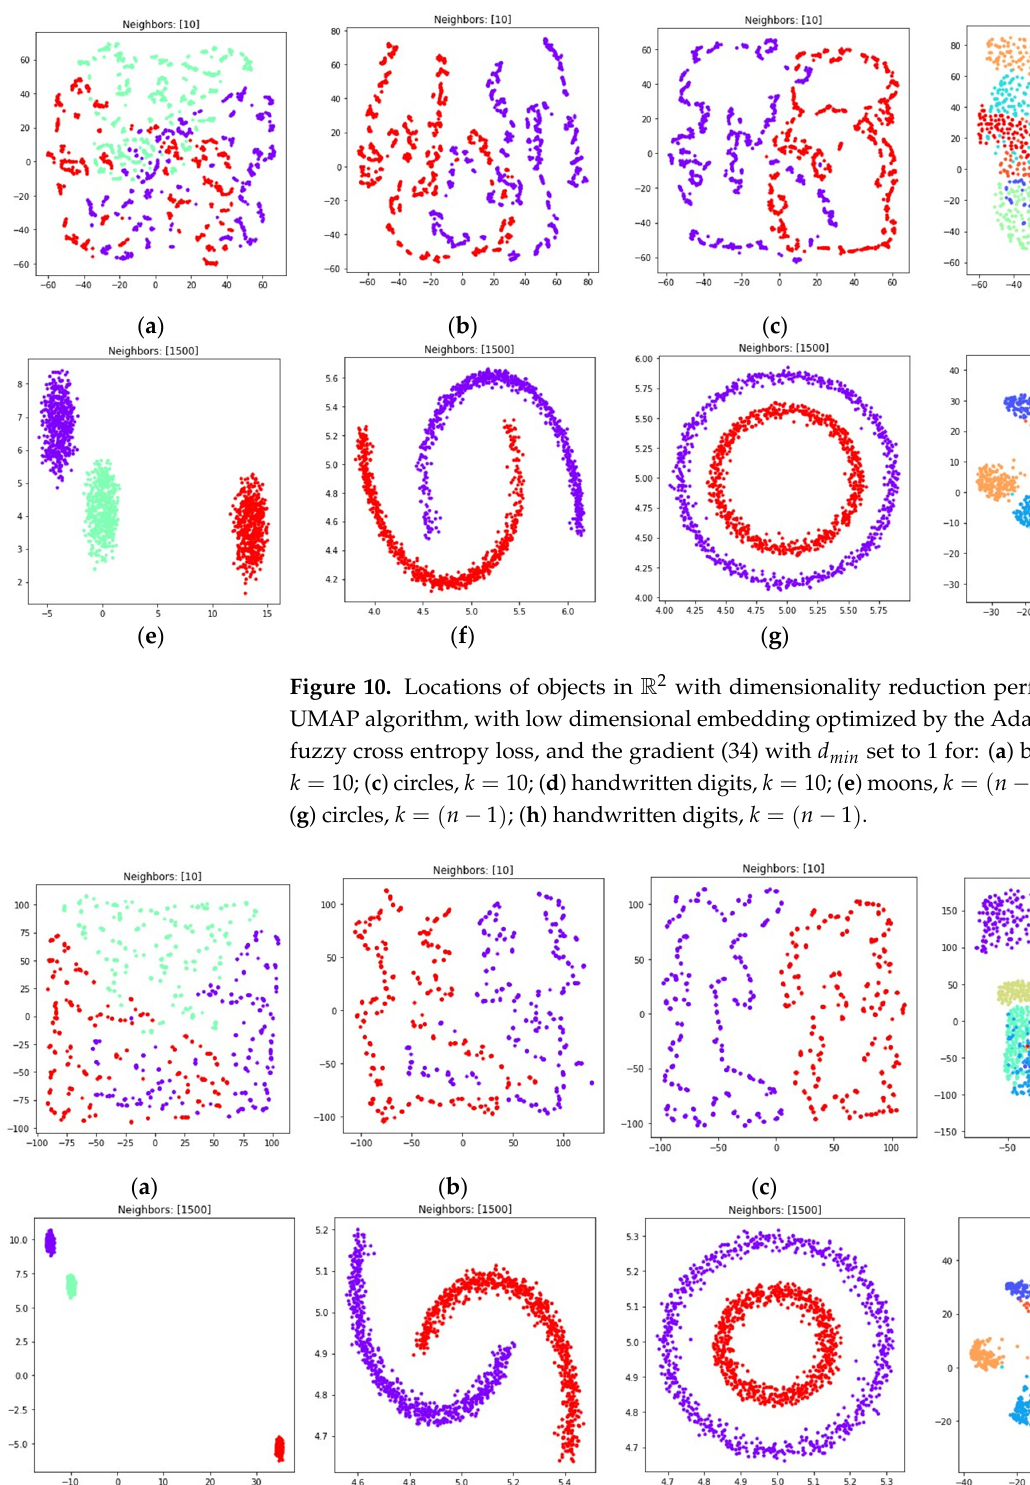
Figure 11. Locations of objects in R 2 with dimensionality reduction performed by applying the UMAP algorithm, with low dimensional embedding optimized by the Adam algorithm, symmetric fuzzy cross entropy loss, and the gradient (34) with d min set to 0.1 for: ( a ) blobs, k = 10; ( b ) moons, k = 10; ( c ) circles, k = 10; ( d ) handwritten digits, k = 10; ( e ) moons, k = ( n − 1 ) ; ( f ) blobs, k = ( n − 1 ) ; ( g ) circles, k = ( n − 1 ) ; ( h ) handwritten digits, k = ( n − 1 )